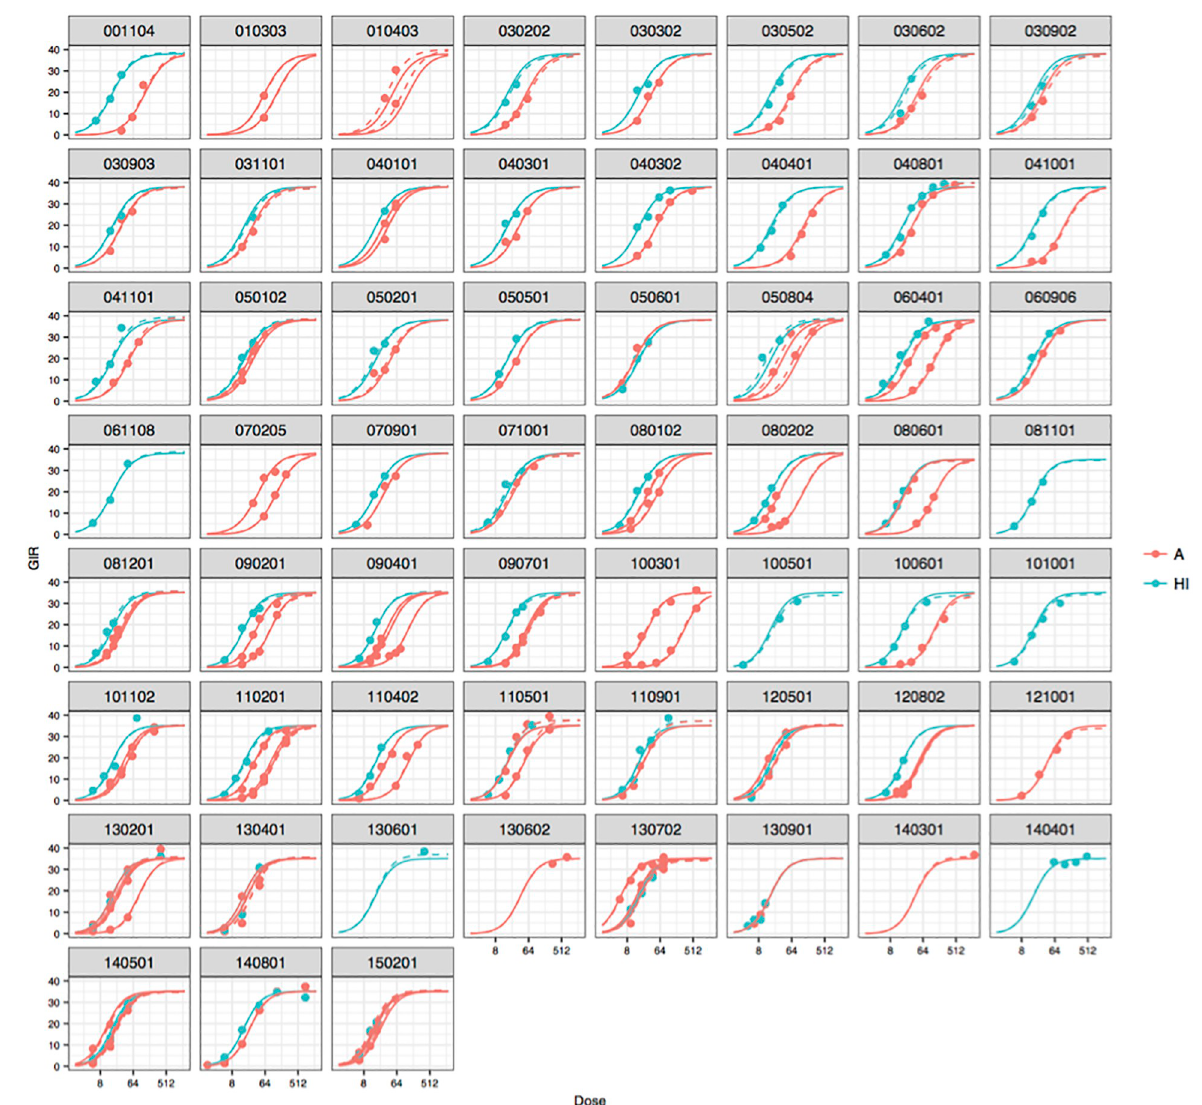
Fig 3. The fits of the mixed-effects model by study and HI or insulin analogue. The solid lines are the population predictions, and the dotted lines are the within-study predictions. The points are the observed GIR values.